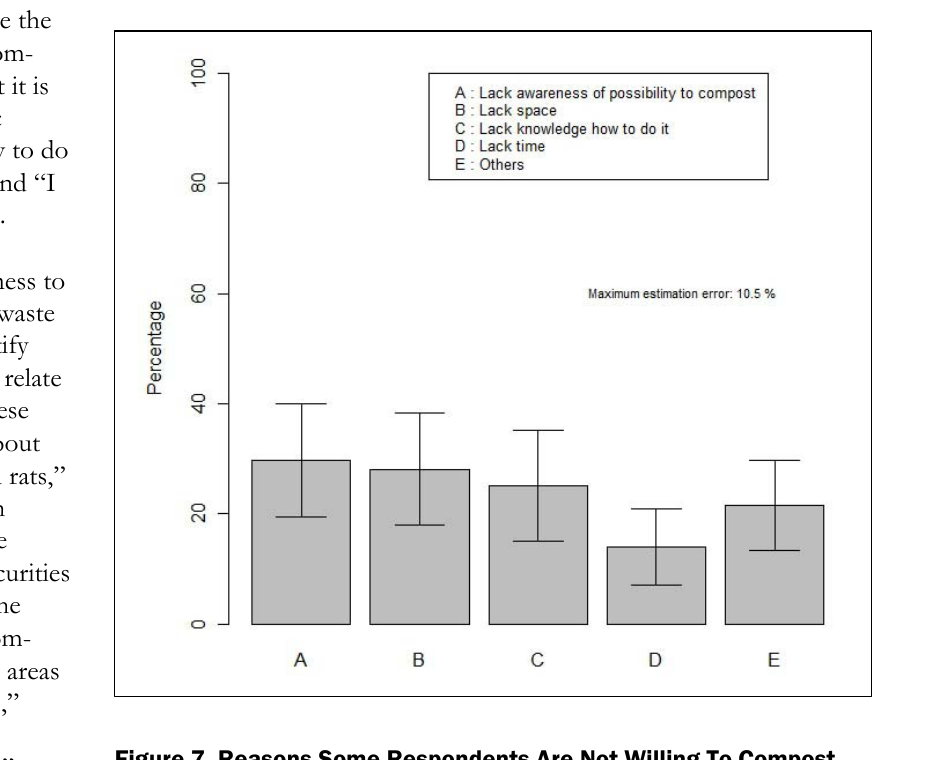
Figure 6. Reasons Why Respondents Willing To Compost Do Not Currently Do So (n=115)